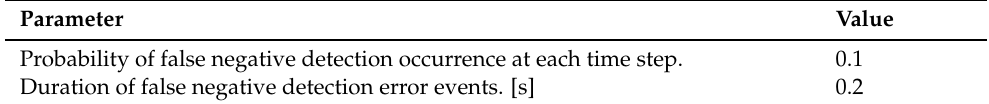
Table A10. Distributions of Scenario E parameters. Ego and object initial state parameters are identical as in Scenario B.